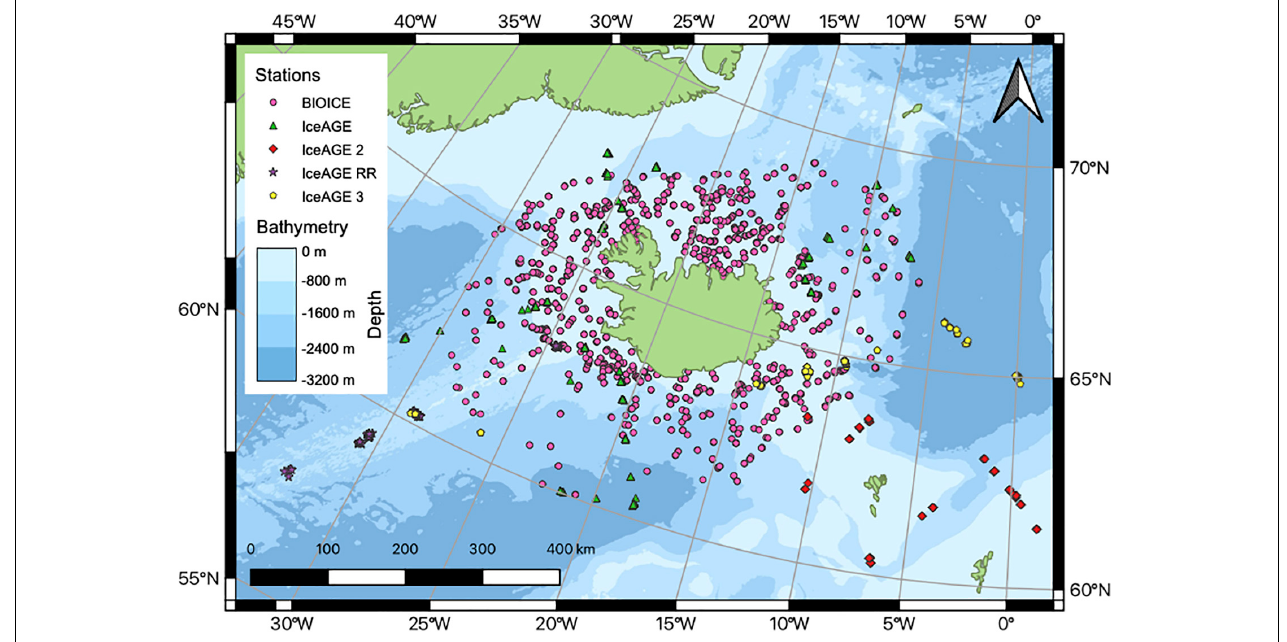
FIGURE 1 | Stations sampled during the BIOICE and IceAGE projects with the latter including the following four expeditions: IceAGE (M85/3), IceAGE 2 (POS456), IceAGE RR (MSM75), IceAGE 3